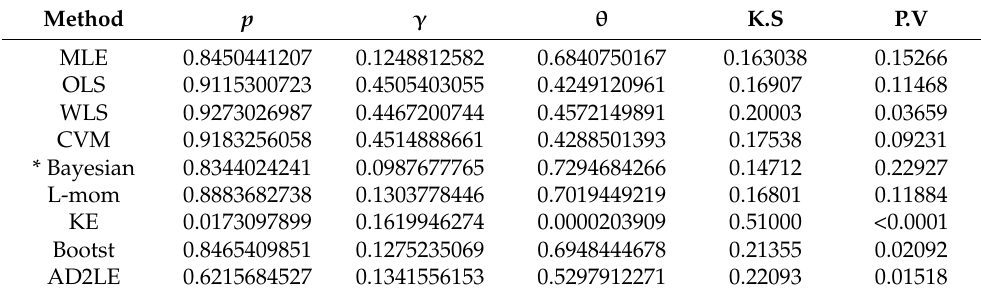
Figure 3. Kaplan–Meier plots based on dataset I. Table 8. Comparing methods using dataset